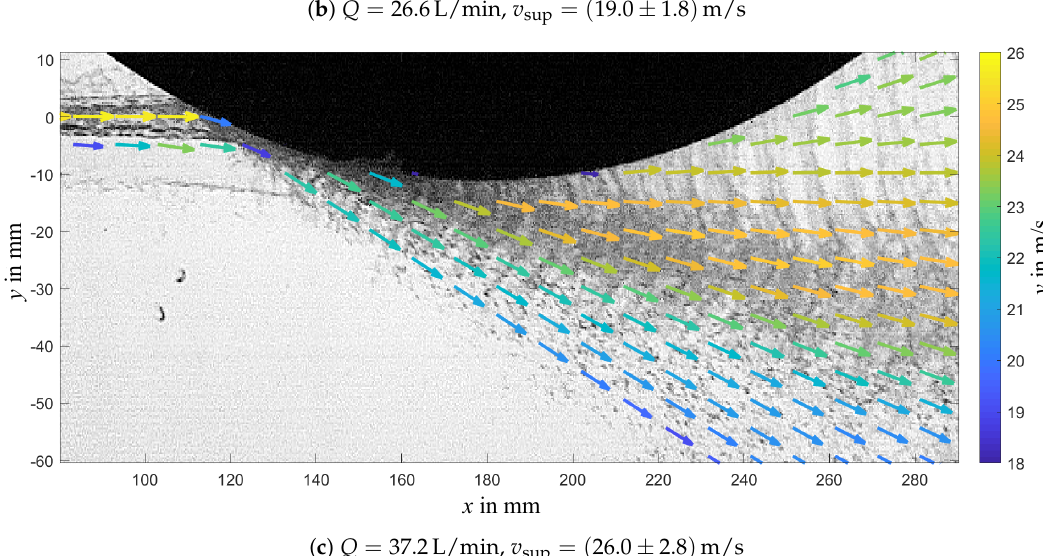
Figure 9. Snapshot of the shadowgram and average velocity field for the MWF flow as colour-coded